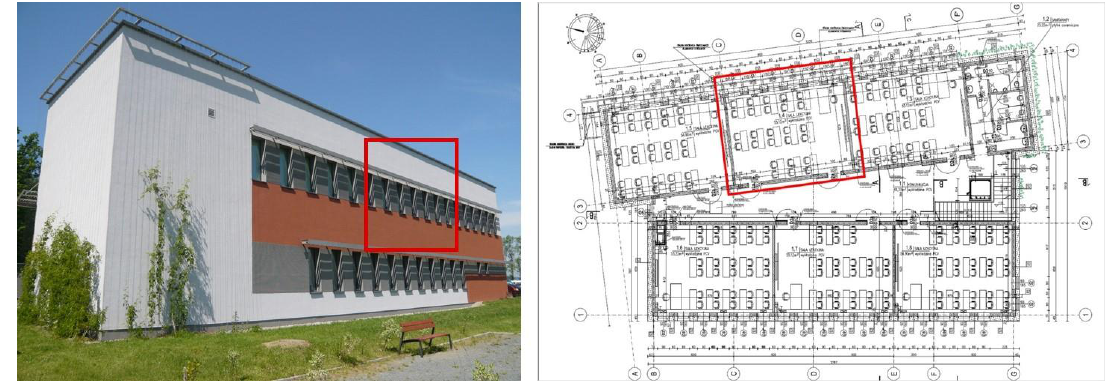
Figure 1. Passive school in Budzów (author’s archive) and a floor plan [27] with the class under study marked.